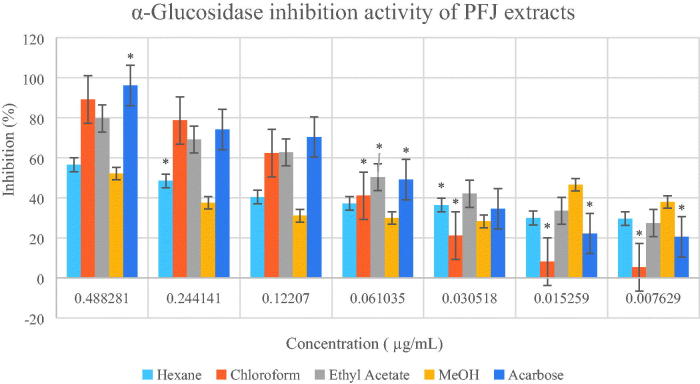
Percentage inhibition of α-glucosidase by different extracts of Paederia foetida twig from Johor, Malaysia. The different extracts were compared with acarbose and p < 0.05 (p = 0.0019). *indicates significance at the 0.05 level.